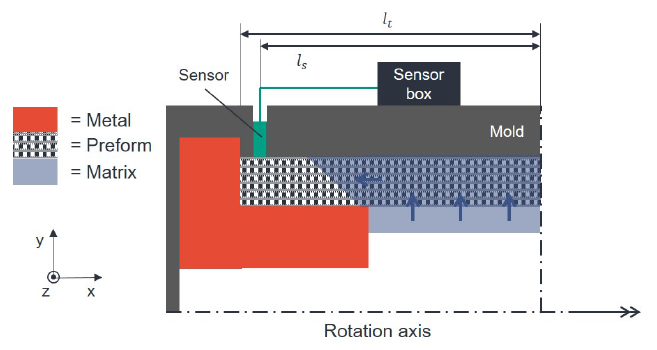
Figure 11. Electrical circuit diagram with capacitive sensor.